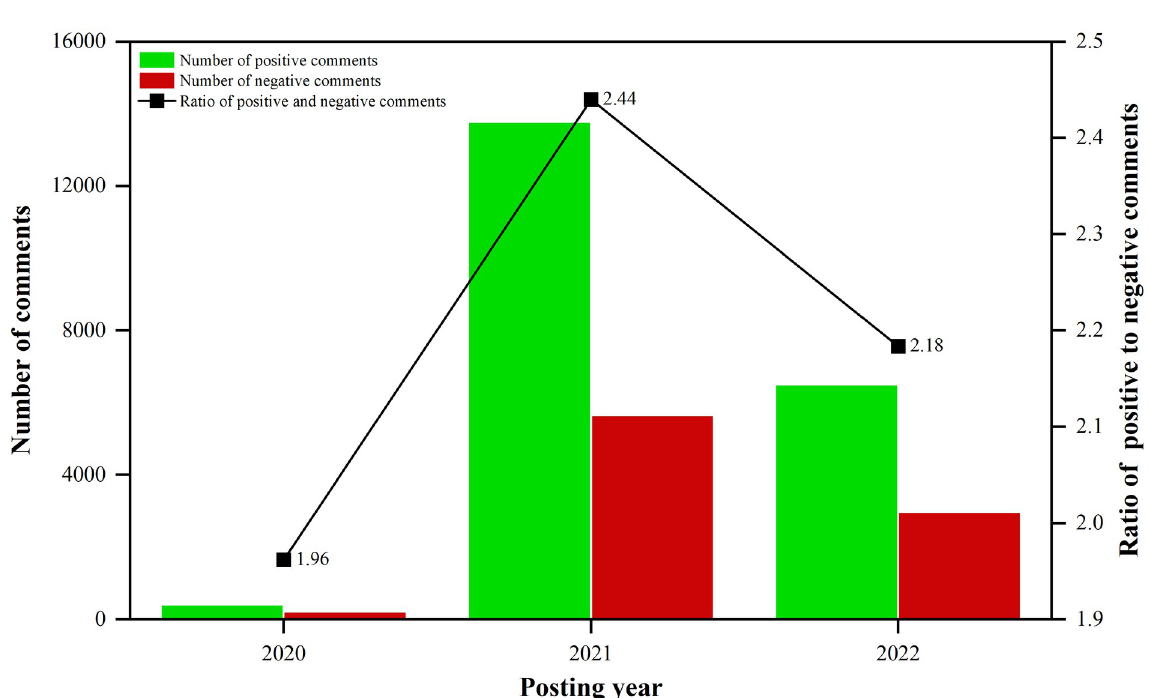
Fig 5. Annual variation of sentiment classification and the ratio of positive to negative